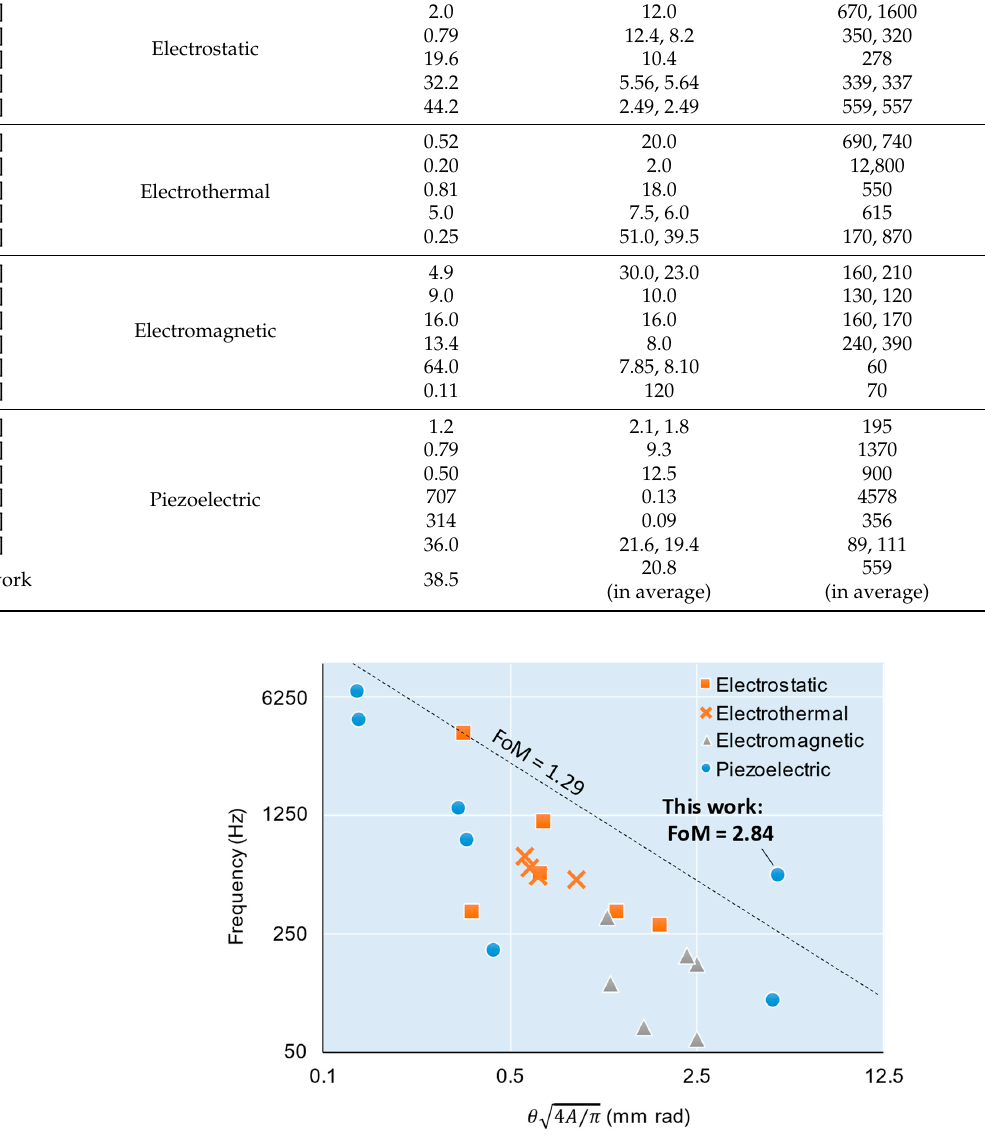
Figure 11. Comparison of 2-DoF quasi-static scanners.